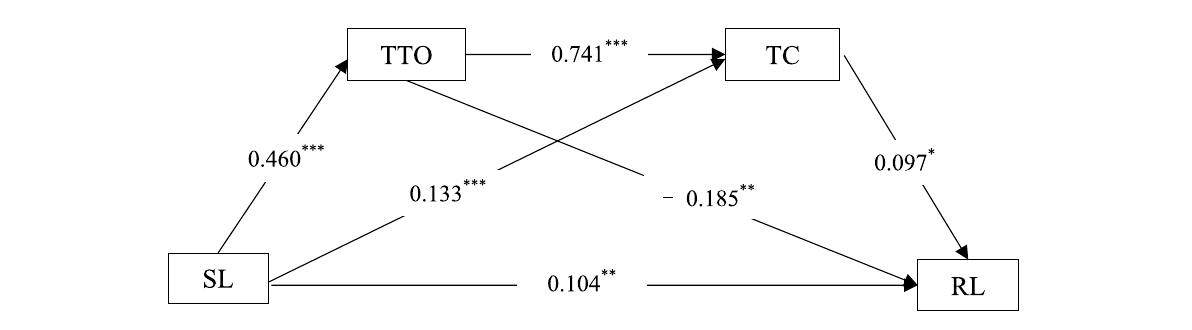
FIGURE 2 Examination of serial mediation: teacher trust in others and teacher commitment as serial mediators. SL, School leadership; TTO, Teacher trust in others; TC, Teacher commitment; RL, Reading literacy. * p < 0.05, ** p < 0.01, *** p < 0.001 (two-tailed).